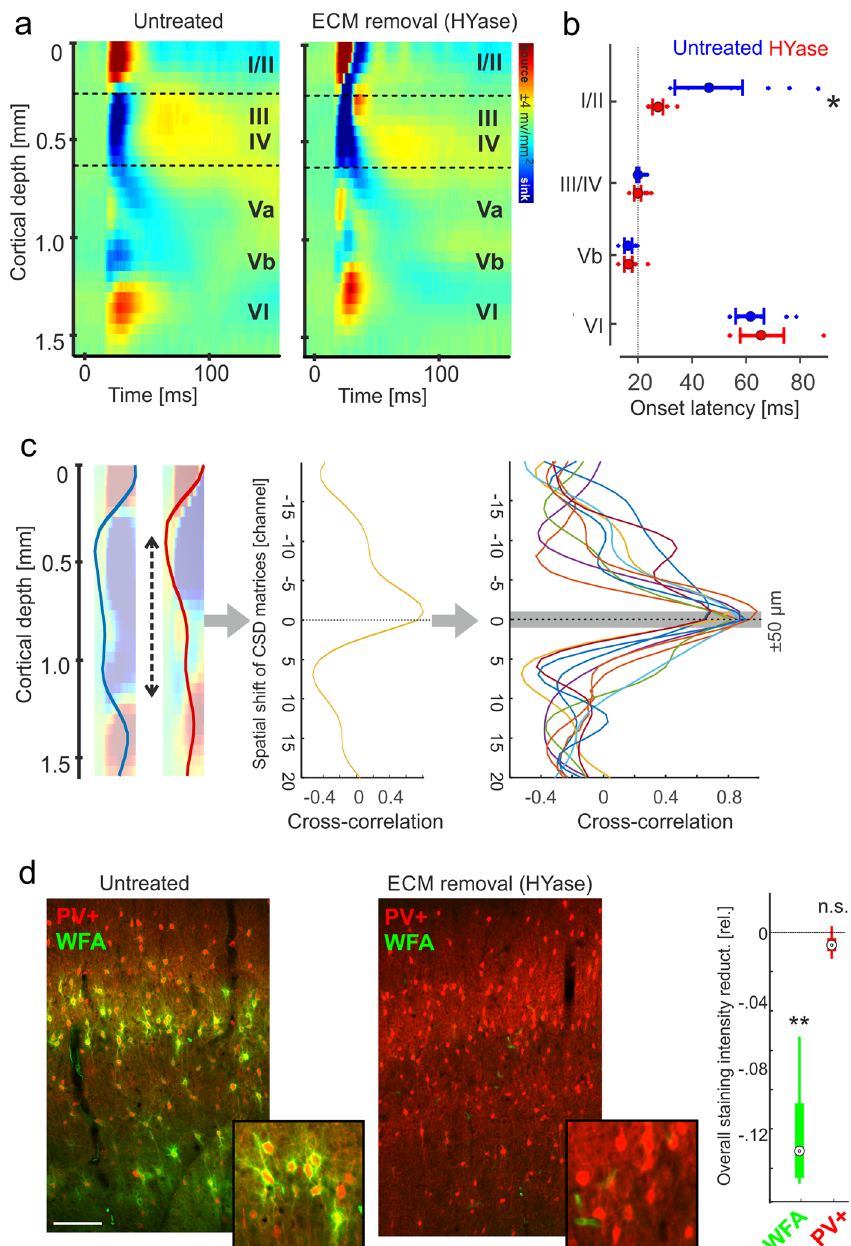
Fig. 1 ECM weakening changed tone-evoked columnar processing in a layer-dependent manner. a Tone-evoked CSD pro fi les display in untreated cortex a canonical feedforward pattern with afferent early sink activity in granular layer III/IV and infragranular layer Vb and subsequent activation of supragranular and infragranular layers. Roman numbers indicate cortical layers. After ECM removal by microinjections of HYase, tone-evoked CSD pro fi les showed reduced strength of the early afferent input in layer Vb and stronger activation of supragranular layers I/II. b Mean onset latencies ±SEM of dominant initial sink components revealed stable onset latencies of early input sinks in cortical layers III/IV and Vb, which are due to thalamocortically relayed input. Current sinks resulting from subsequent intracortical processing showed variability ( n = 9; *Student ’ s t-test p < 0.05). Single dots represent individual data points of each animal. c In order to quantify the stability of the cortical laminae along the derivation axis and thus the comparability of the patterns before and after enzyme administration, we have cross-correlated the early onset CSD pro fi le of each animal before and after HYase injection. Relative changes of overlapping sinks and sources of the electric fi eld may occur, while the general spatial pro fi le should be stable. The highest correlation should then be at a zero-lag shift, while shifts of the electrode relative to cortical layers should be detectable by a shift in the peak of the cross-correlogram. Correlation peaks in our data set were all found with at 0 ± 1 channel shift corresponding to a maximal shift of ± 0.05 mm. d Immunostainings after HYase treatment also revealed reduced density of WFA staining and hence reduced PNNs around PV + interneurons. High-resolution confocal microscopy images (Zeiss LSM 700, Germany) show PV (red) and WFA (green) staining in the vicinity of the recording site. Stainings reveal layer-dependent densities of PNN structures in the auditory cortex. White scale bar indicates 200 µ m. Right , Box plots represent the median (circle) and the interquartile range (25% and 75% percentile) and whiskers represent the full range of data ( n = 4). Gray values of the WFA staining were signi fi cantly reduced for the HYase-treated side (Student ’ s t-test; p < 0.002), but did not differ for PV + ( p > 0.05).